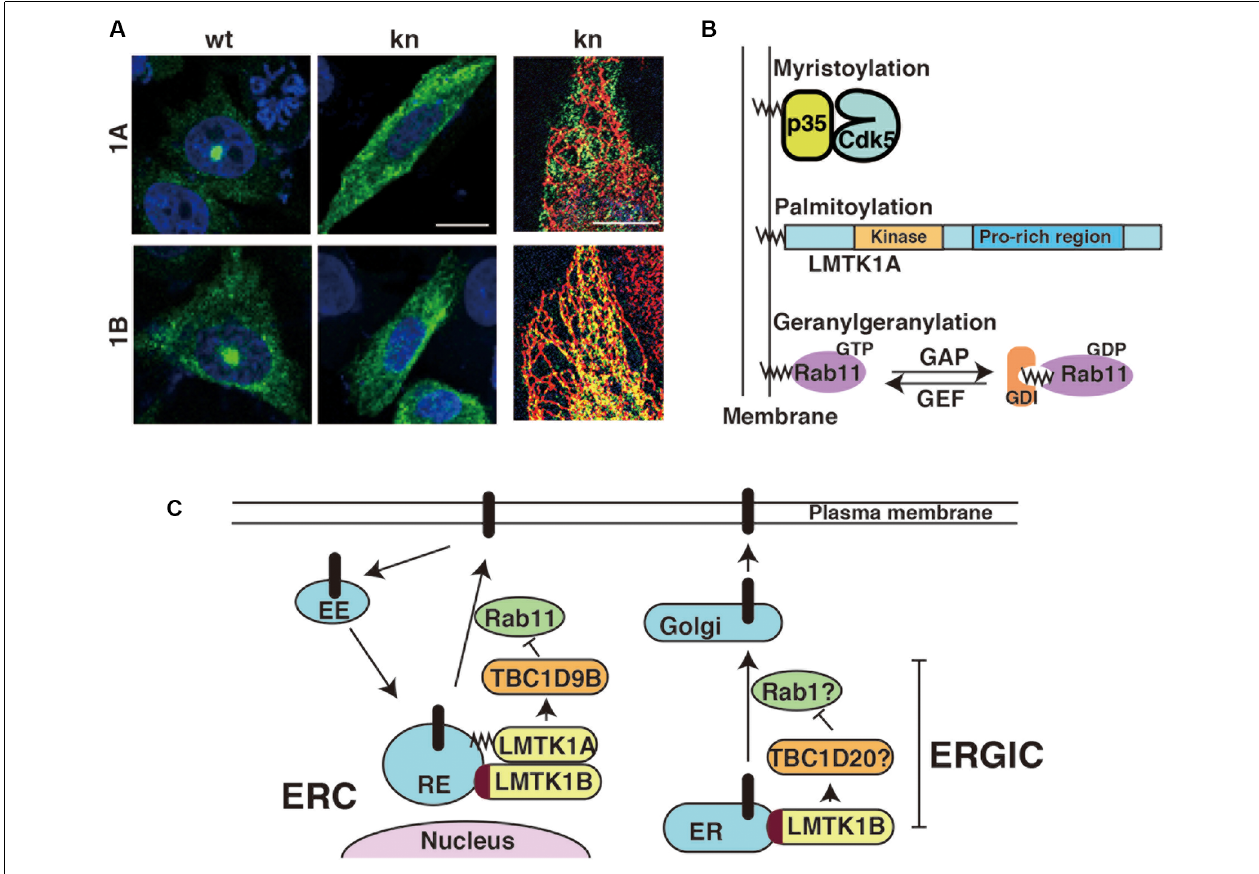
FIGURE 2 | Subcellular localization of LMTK1A and LMTK1B and the regulation of vesicle trafficking at the perinuclear endosomal recycling compartment (ERC) or ERGIC. (A) Immunostaining of wild type (WT) and kinase negative (KN) mutants of LMTK1A (1A) and LMTK1B (1B) expressed in CHO-K1 cells. SIM superresolution microscopic images in the right show the localization of LMTK1B KN, but not LMTK1A KN, on ER stained with a KDEL ER marker. Bars represent 20 and 5 µ m, respectively (modified from Wei et al., 2020). (B) Proteins regulating endosomal trafficking bind to endosomal membranes through different binding modes. Cdk5 associated with the membranes through the myristoylation of the N-terminal glycine of its activator protein p35. LMTK1A accumulates on endosomes through the palmitoylation of cysteine residues in the N-terminal region. Active Rab11 binds to endosomes via the geranylgeranylation of the C-terminal cysteine. GDI is a GDP dissociation inhibitor, which binds to the GDP-bound form of Rabs in the cytosol. (C) LMTK1A and LMTK1B bind to recycling endosomes (RE) at the perinuclear ERC and regulate Rab11-dependent endosomal transport through TBC1D9B Rab11 GAP. LMTK1B is a transmembrane protein that would be synthesized on the ER and transported to the perinuclear ERC via vesicle transport. Because LMTK1B KN is localized to the elongated tubular ER, LMTK1B likely regulates vesicle transport at the ERGIC. The mechanism might be similar to transport at the perinuclear ERC; TBC1D20 and Rab1 are described as possible downstream candidates. EE represents the early endosome and Golgi represents the Golgi